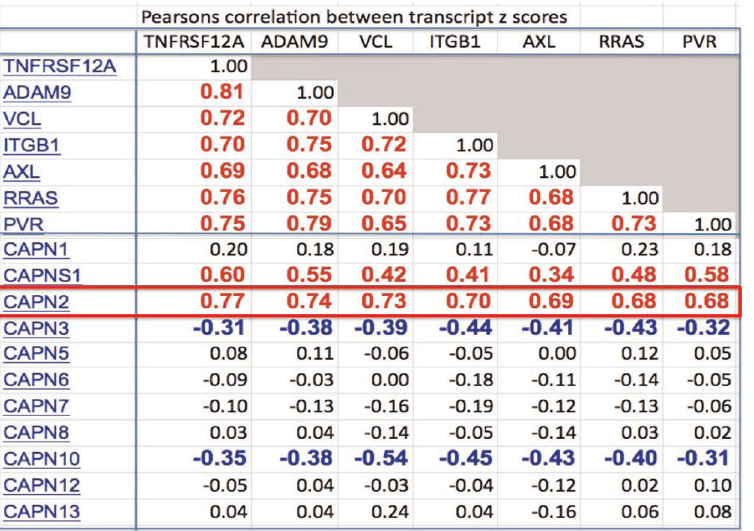
Figure 10. Expression profile correlations of calpain family genes and key genes the HCCS15 high cross-correlation subset. Expression data for CAPN4 and CAPN11 were not available. CAPNS1 is known to function together with CAPN2.